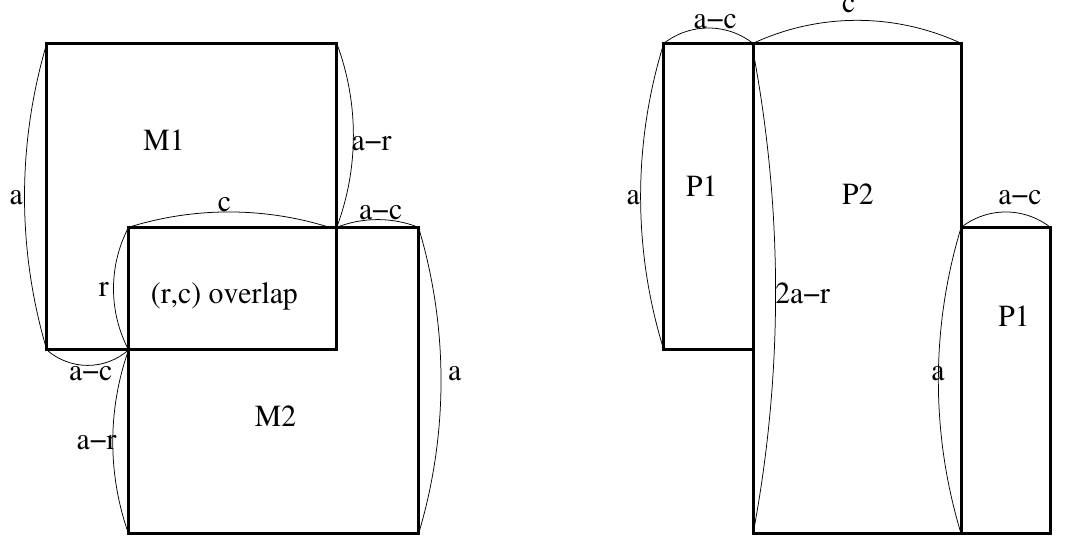
Fig. 1: An ( r, c ) -overlap of two a × a sub-matrices M 1 and M 2 (left figure); P ( r, c ) = P 1 P 2 P 1 where P 1 = P a − c a and P 2 = P c 2 a − r (right